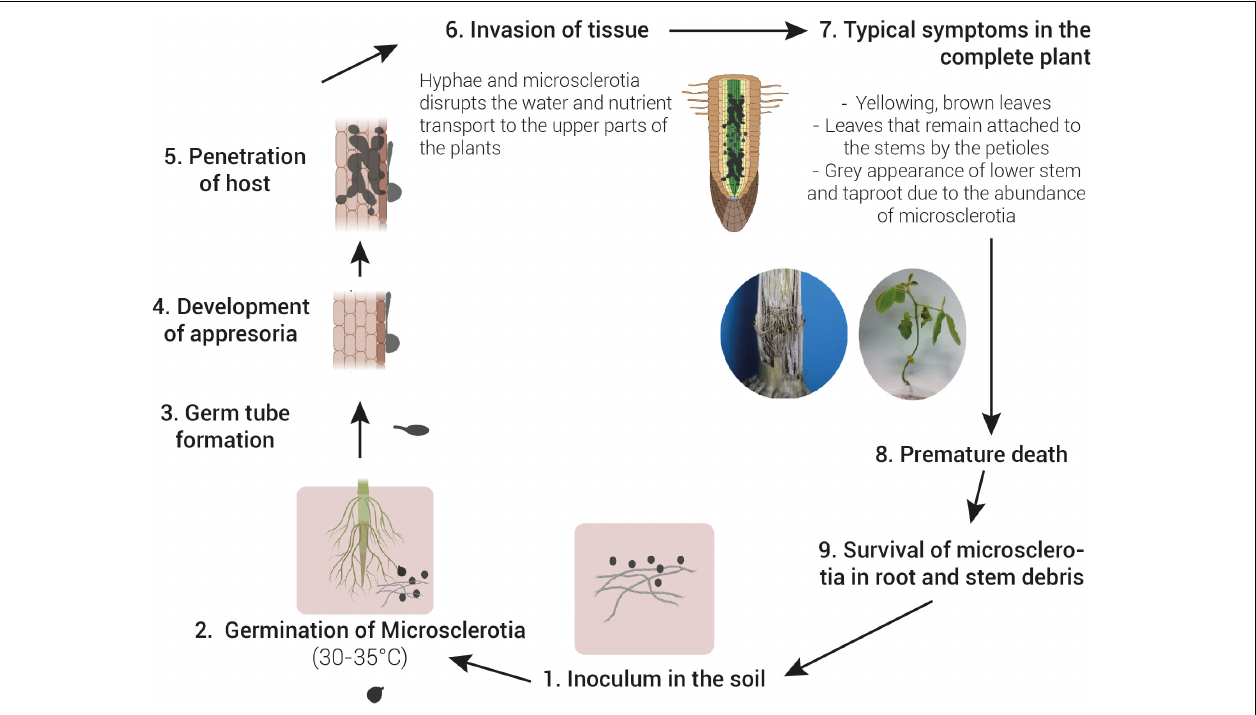
FIGURE 1 | Disease cycle of charcoal rot caused by Macrophomina phaseolina . Microsclerotia present in soil is the primary source of inoculum. Microsclerotia germinate (30–35 ◦ C) and form a germ tube followed by the development of an appresoria to penetrates through the host epidermis. Once in the roots, the fungus affects the vascular system, disrupting the water and nutrient transport to the upper parts of the plants. This causes wilting of the plant and a typical grey appearance of stem tissues due to the abundance of microsclerotia. Under severe disease and favourable environmental conditions, a premature death of the host plant often occur. Microsclerotia in root and stem debris return to the soil and can either begin a new disease cycle or survive in soil up to 15